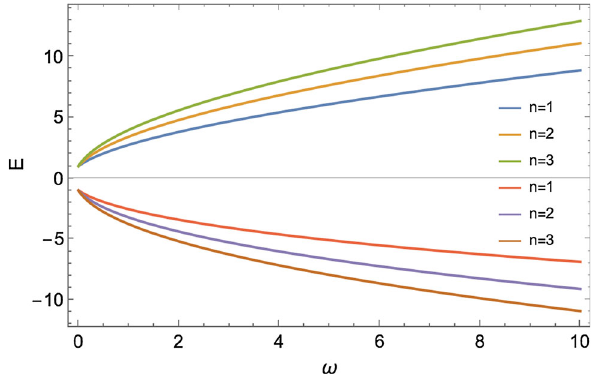
Fig. 3 Energy spectrum with s = − 1 as a function of ω , with M = 1, m = 1 / 2, a = 0 . 1 and α = 0 . 2 for different values of